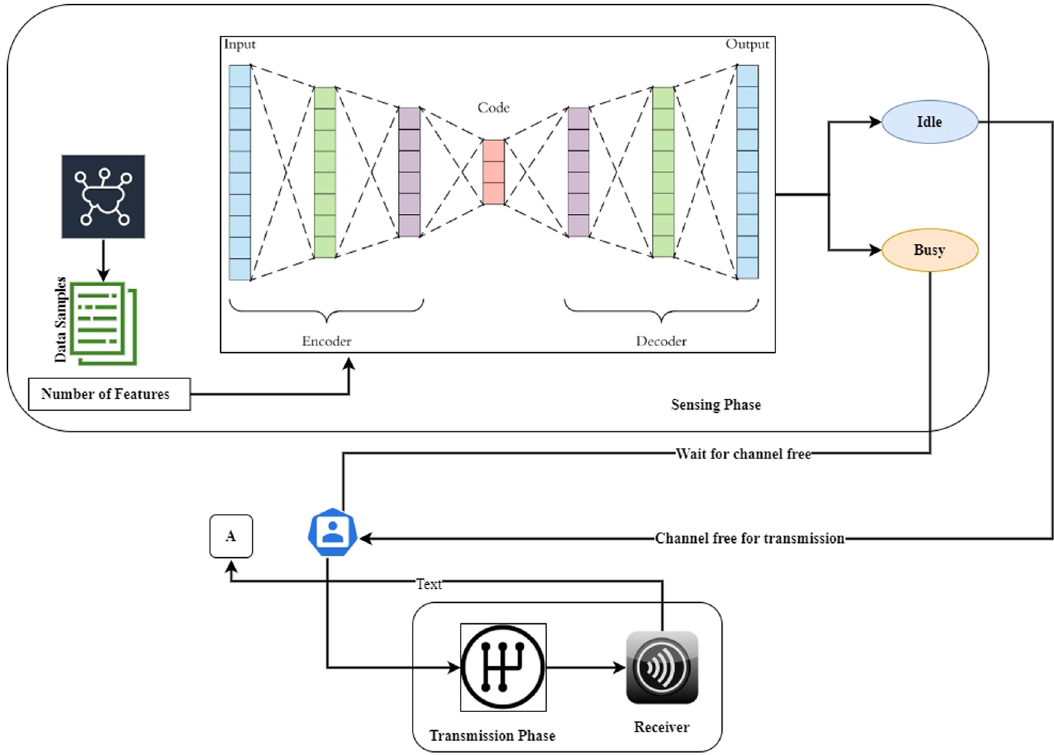
Figure 1: Three - phase of AENN IoT data transmission